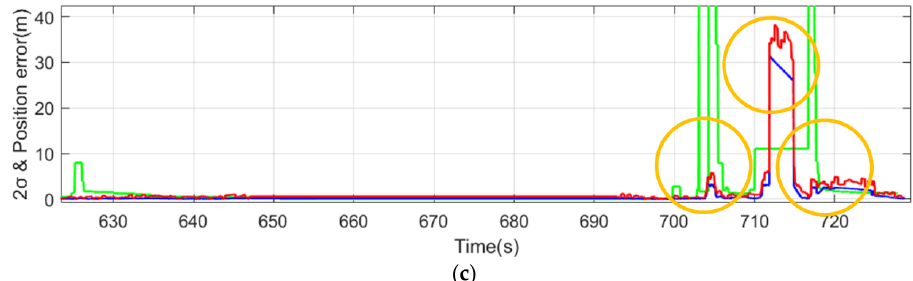
Figure 9. Comparison of the estimated error between the proposed method (blue line) and the conventional method (green line).